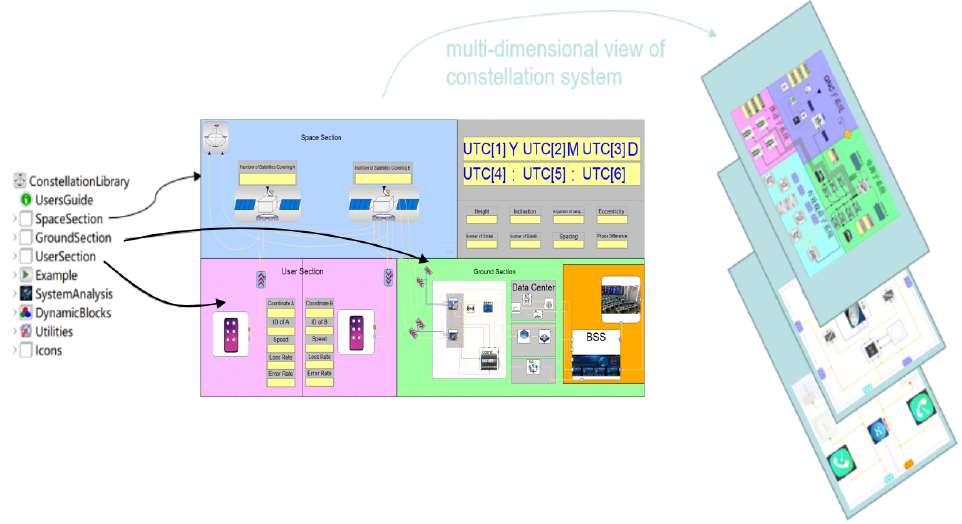
Figure 11. Example satellite constellation system model.